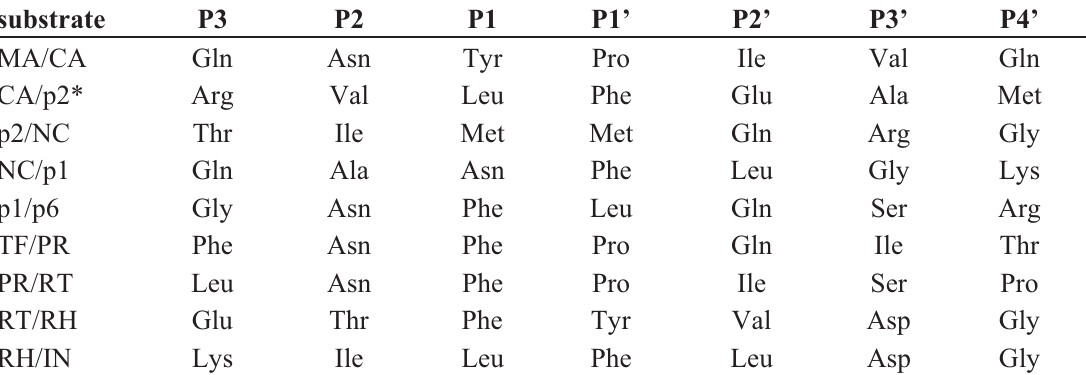
Table 6. Sequences of the nine HIV-1 protease cleavage sites within the HIV-1 Gag-Pol